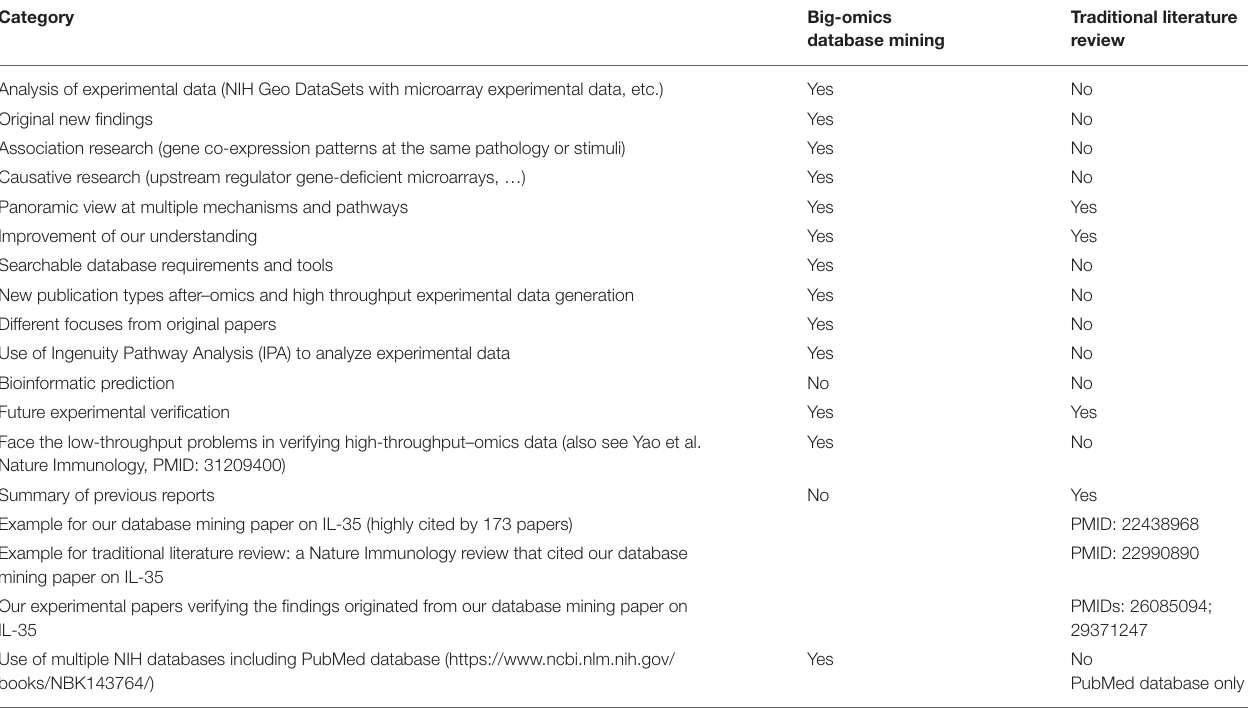
TABLE 1 | A novel research publication type utilizing big-omics experimental database mining analyses leads to original new findings and generates new